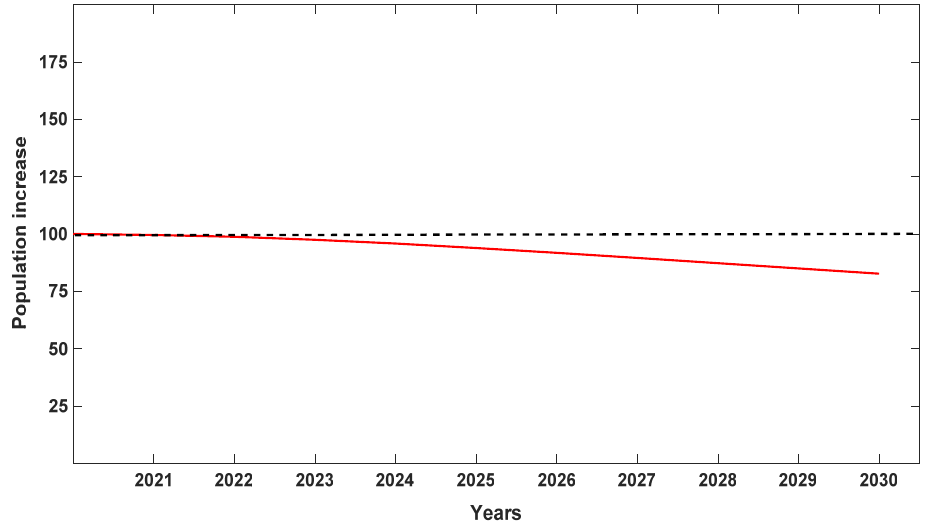
Figure 5. Projection of the behavior of Dendrophylax lindenii within the Florida Panther National Wildlife Refuge during the next 10 years for all seven populations combined. This graph suggests a 20% drop in ghost orchid numbers by 2030 in the absence of external adverse factors (e.g., hurricanes). If external factors are considered, the decline would be expected to